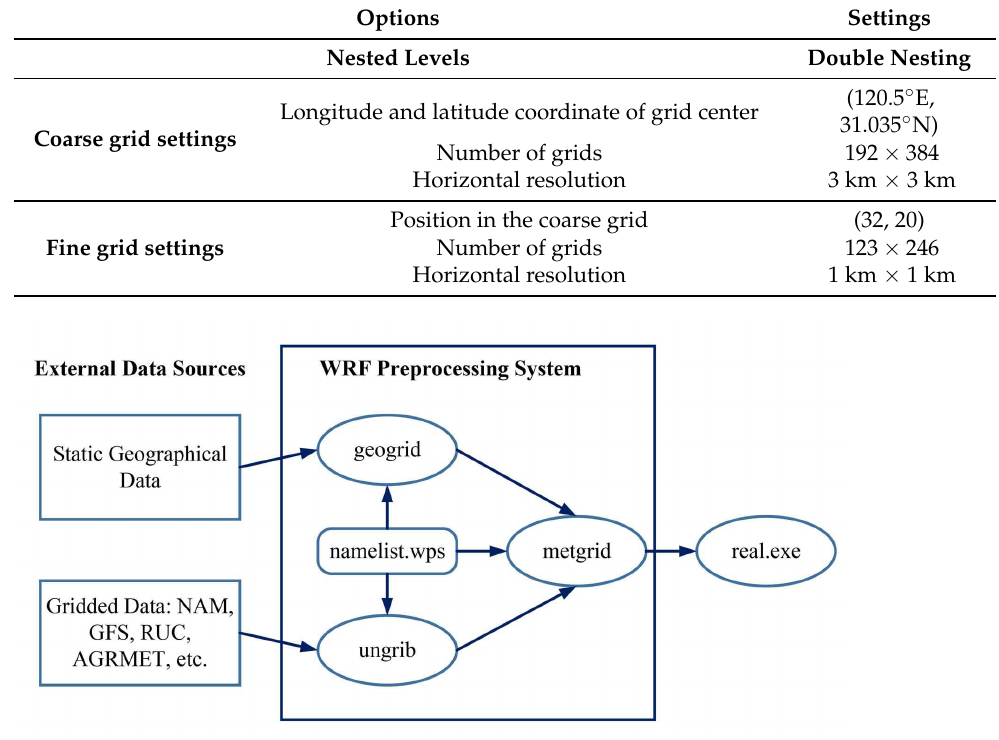
Figure 1. Procedures of the WRF pre-processing